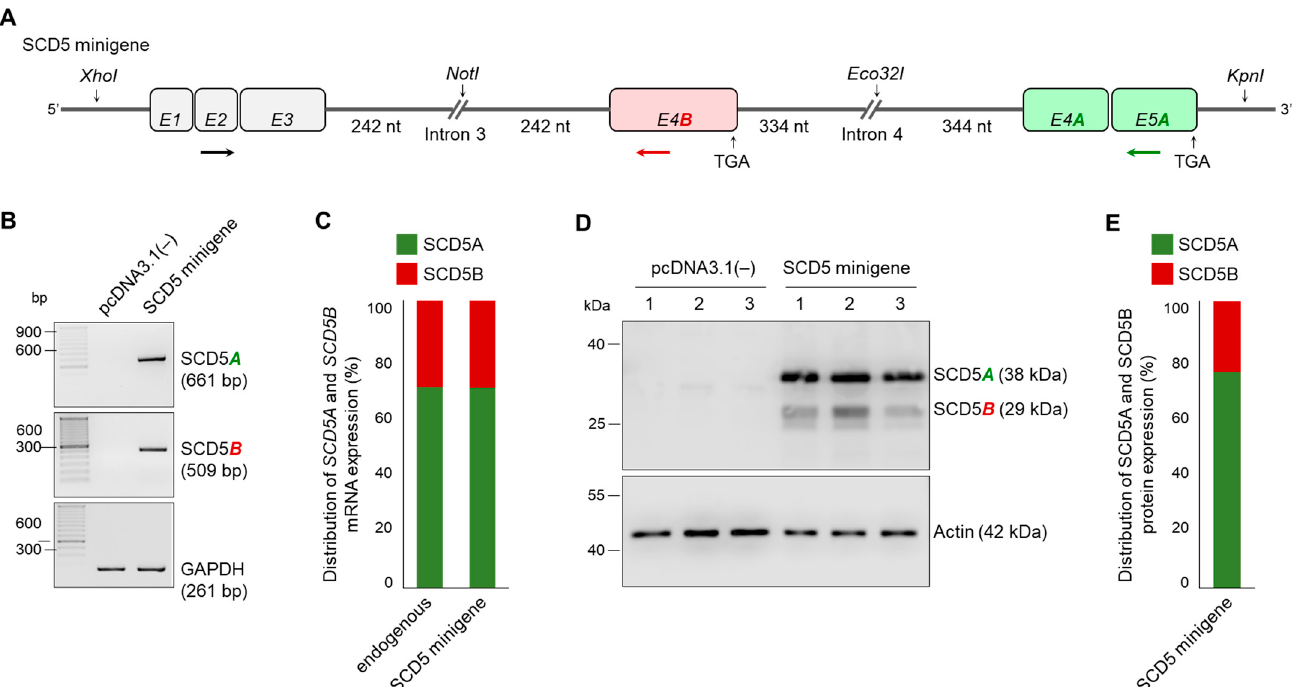
Figure 4. Minigene analysis of unequal SCD5 alternative splicing in HEK293T cells. ( A ) Schematic structure of SCD5 minigene construct. Exons are numbered and marked with rectangles. The length of the segments cloned from 5 ′ and 3 ′ regions of introns 3 and 4 are also shown. The stop codons and restriction endonuclease cleavage sites are indicated. RT-PCR primers used to verify A- and B-specific splicing events are indicated by arrows. SCD5A - and SCD5B -specific and shared primers are shown in green, red and black, respectively. ( B ) Verification of AS in HEK293T cells transfected with the SCD5 minigene plasmid. The RT-PCR products specific for SCD5 transcript variants were separated and visualized on 2% agarose gel. GAPDH served as an endogenous control. Representative results of four independent experiments are shown. ( C ) The distribution of endogenous and SCD5 minigene-derived SCD5A and SCD5B expression was measured by qPCR and is represented on a percentage scale. Experiments were performed in triplicate. The S.D. values are shown in Table S6. ( D ) SCD5A and SCD5B protein levels were detected by immunoblotting in samples prepared from pcDNA3.1( − ) and SCD5 minigene transfected cells. HEK293T cells were harvested and processed 24 h after transfection. Aliquots of cell lysates (5 µg) were loaded on 15% SDS-polyacrylamide gel, transferred to Immobilon-P membrane, and detected by SCD5-speci fi c antibody. Actin was measured as a loading control. Representative immunoblots of six independent experiments are shown. ( E ) The band intensities of immunoblots were quanti fi ed by densitometry and SCD5 protein distribution is represented on a percentage scale. The S.D. values are shown in Table S6.